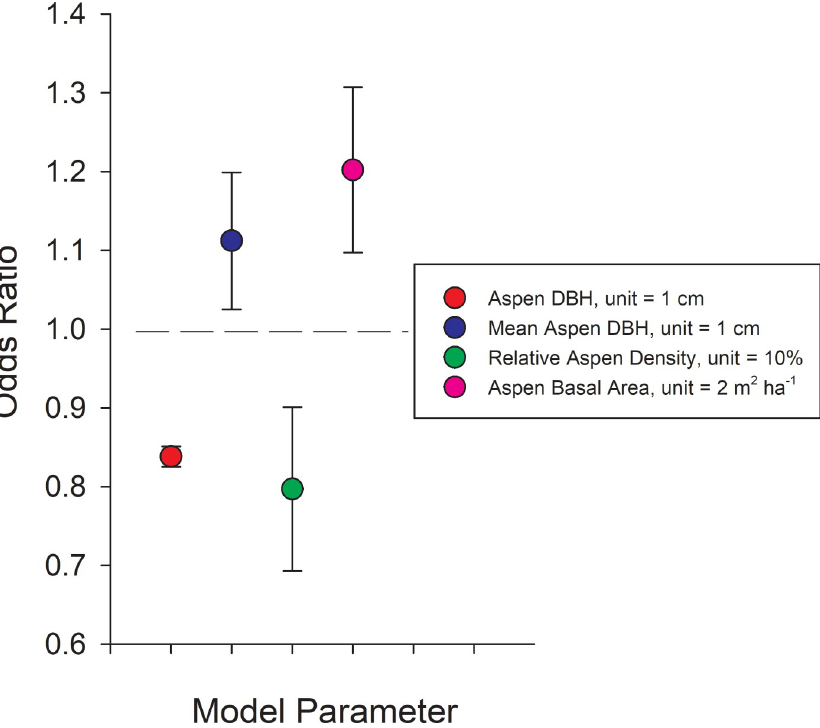
Fig 6. Modeling canker incidence based on stand parameters. Odds ratios for stand structural parameters from the mixed-effects logistic model: Logit ( π ) = log ( π /(1- π )) = –0.761–0.177 � DBH – 0.023 � Relative Aspen Density + 0.092 � Aspen Basal Area + 0.106 � Mean Aspen DBH – 1.413 � CK – 3.263 � CR —0.358 � RM + 0.692 � TKL – 0.736 � NOM . Ecoregion β values are computed relative to YTU which does not appear in the model and has a log (odds) = the intercept when all other factors are 0. Variables with odds ratios significantly greater than 1.0 indicate a significant increase the odds of canker infection while those below 1.0 indicate a significant reduction in the probability of canker infection. For example, an odds ratio of 0.838 (red dot) means that for every 1 cm increase in DBH of a given aspen tree, the odds of having canker is reduced by 16.2% (= (1–0.839) � 100), while an odds ratio of 1.112 (blue dot) means that every 1 cm increase in average stand-level DBH (a surrogate for stand age) increased the odds of having canker by 11.2% ((1.112–1) � 100). Ecoregion abbreviations follow Fig 4.